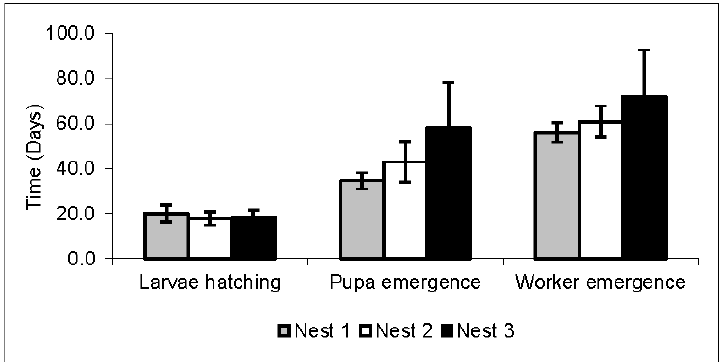
Figure 4. Average time and standard deviation for the hatching of the larva, and the emergence of the pupa and worker (adult) of Acromyrmex rugosus rugosus in three nests. Temperature: 24 °C.